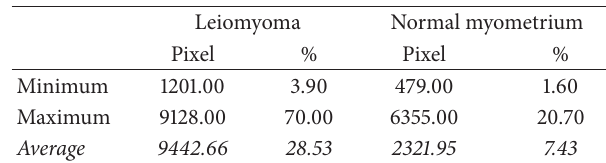
Table 1: Interstitial collagen average area ∗ per histological field in uterine tissue from